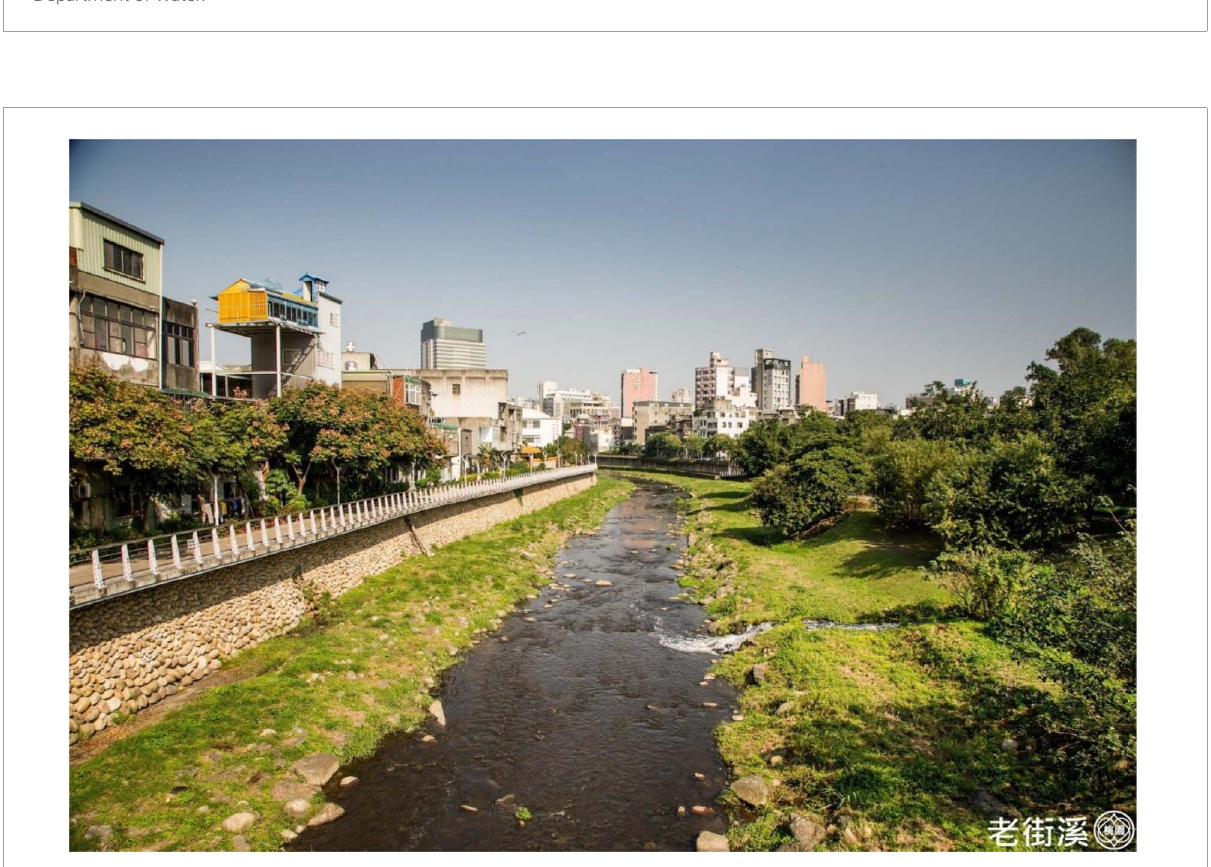
FIGURE15 The Laojie Stream and its riparian zone. ©Taoyuan City Government